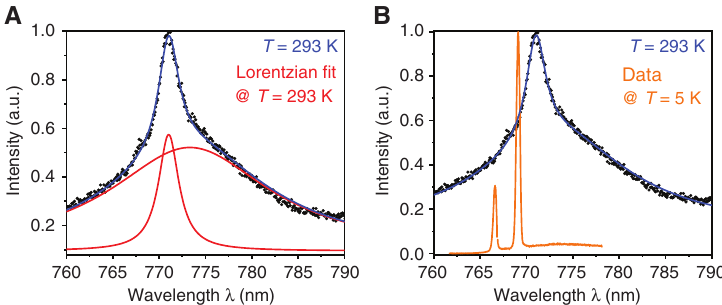
Figure 3: Photoluminescence spectrum of a typical emitter in hBN at room and cryogenic temperatures. The black dots and blue lines are measured data and bi-Lorentzian fits to the data, respectively, at room temperature. The two red lines in (A) represent the individual Lorentzians of the bi-Lorentzian fit. The orange curve in (B) corresponds to the emission spectrum at 5 K.